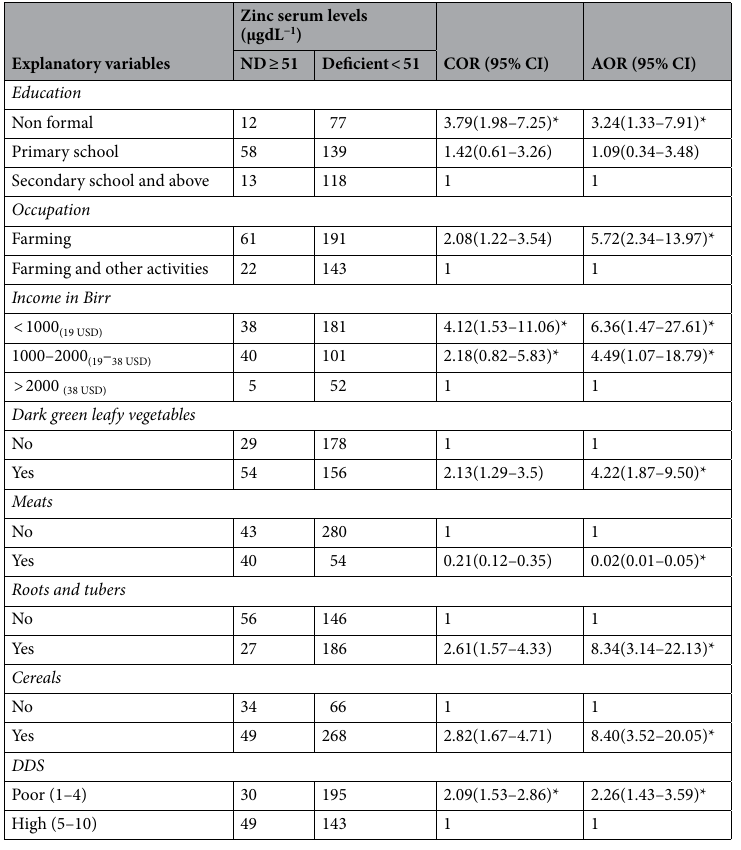
Table 4. Results of logistic regression model for risk factors associated with zinc deficiency of pregnant women small-scale farmers in Kellem Wellega zone, western Ethiopia, 2021. AOR adjusted odds ratio, COR crude odds ratio, CI confidence interval; other activities: (daily labourer, private business, non-Government and civil servants), ND non deficient; and *represent the level of significance at p values less than